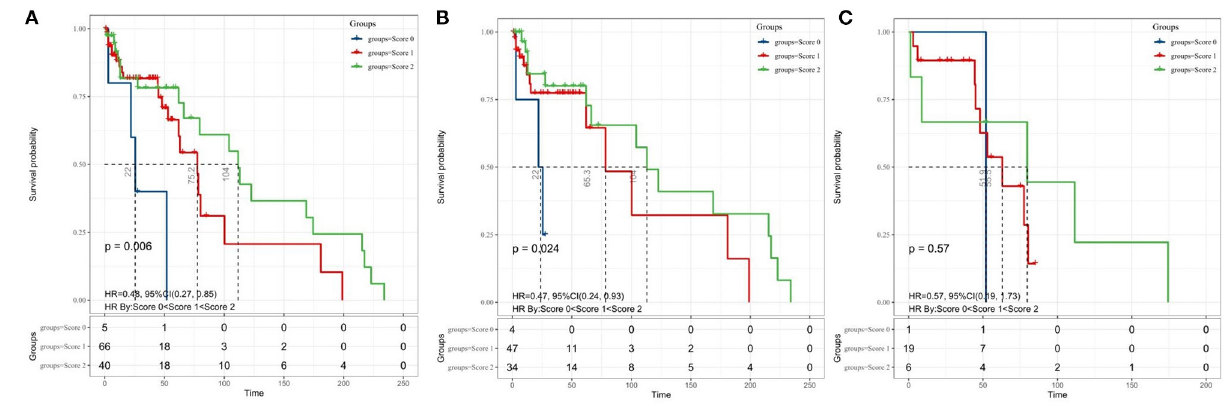
and distant tumor-host crosstalk (18). Expression of platelet- derived growth factors was also common in gliomas